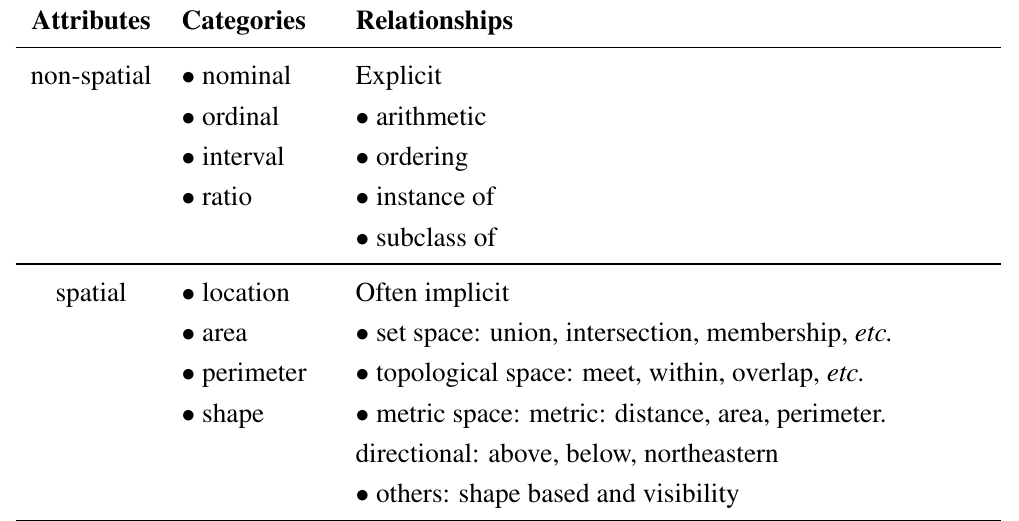
Table 2. Common Relationships among Non-spatial and Spatial Attributes.